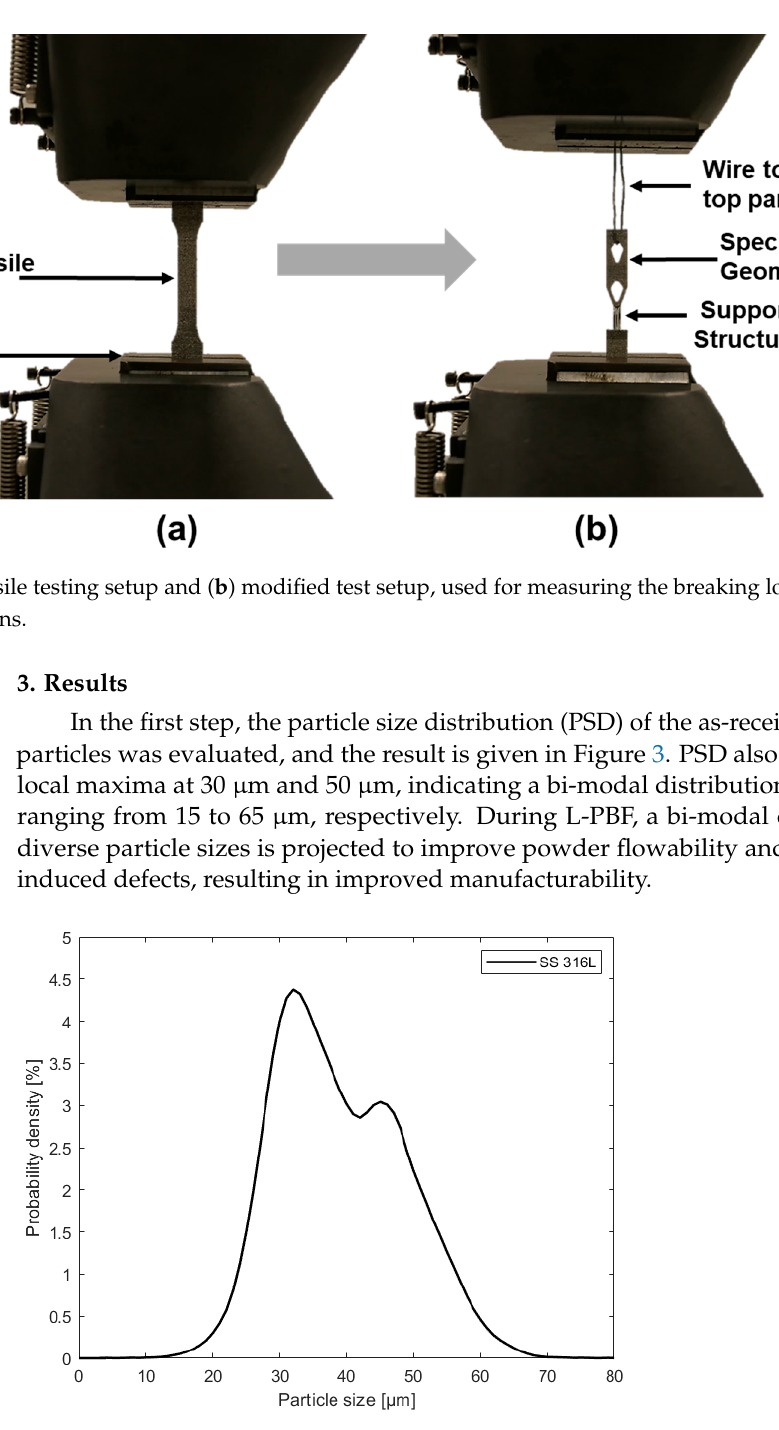
Figure 3. Particle size distribution of the as-received SS316L powder .